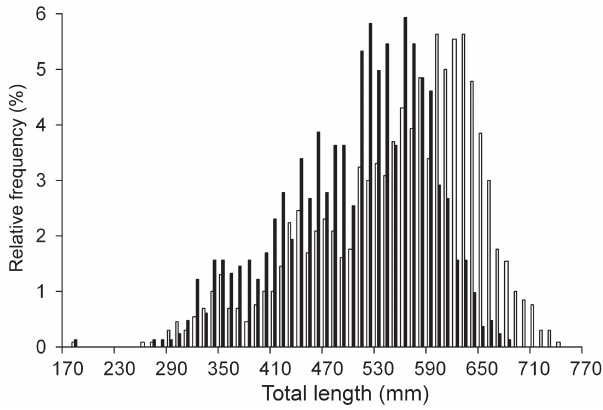
Fig. 2. Size frequency distribution of the individuals analyzed of Sympterygia bonapartii from San Matías Gulf (Argentina). Males (■) n = 827 and females (□) n =